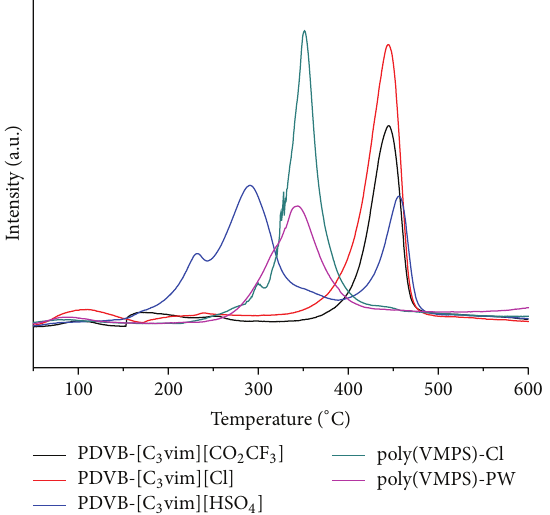
Figure 5: The effect of reaction temperature and time on catalytic one-pot dehydrative etherification of fructose in ethanol to EMF with poly(VMPS)-PW.